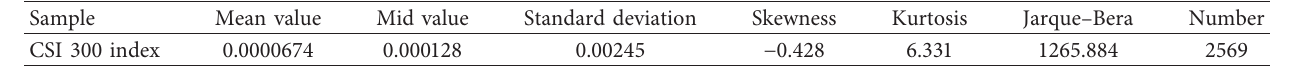
Table 1: The basic statistical characteristics of the rate of return of the CSI index. Sample